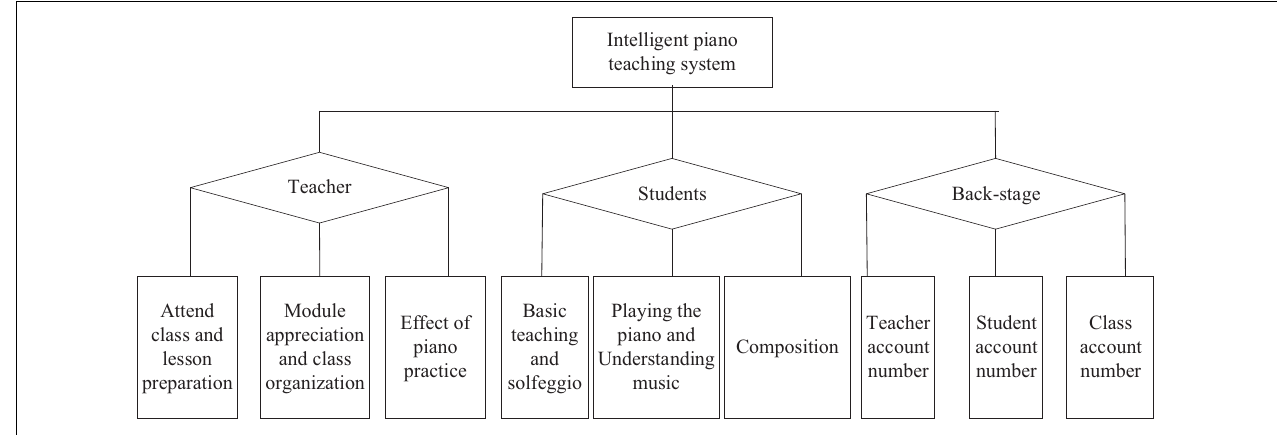
FIGURE 5 | Intelligent piano teaching system.